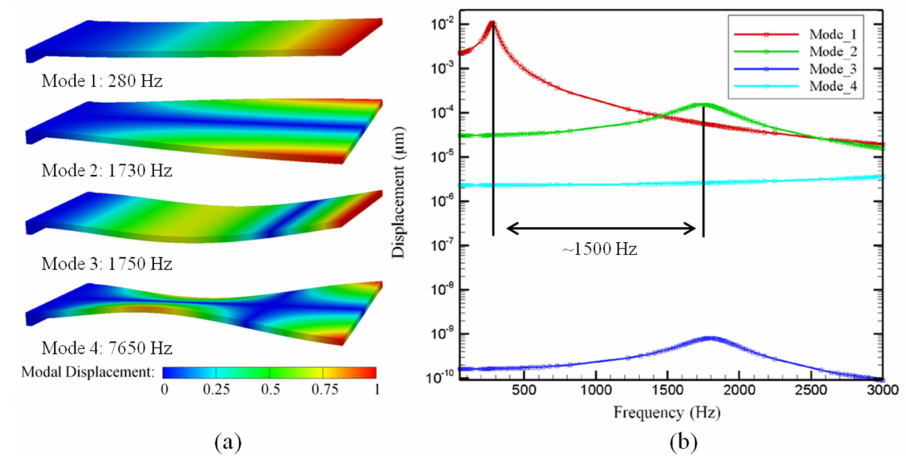
Figure 2. CoventorWare ® simulation results showing ( a ) first four modal harmonics of a simulated 7 ˆ 2 ˆ 0.01 mm 3 cantilever and ( b ) the amount of tip deflection that occurs at these